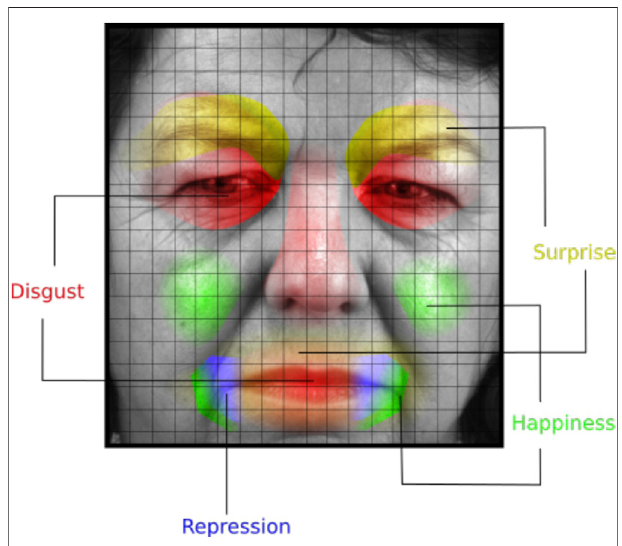
FIGURE 2 | Regions of interest and the corresponding emotions. Image reproducedfromtheSAMMdatabasewithpermissionfromDavisonA.Ketal. (2018).